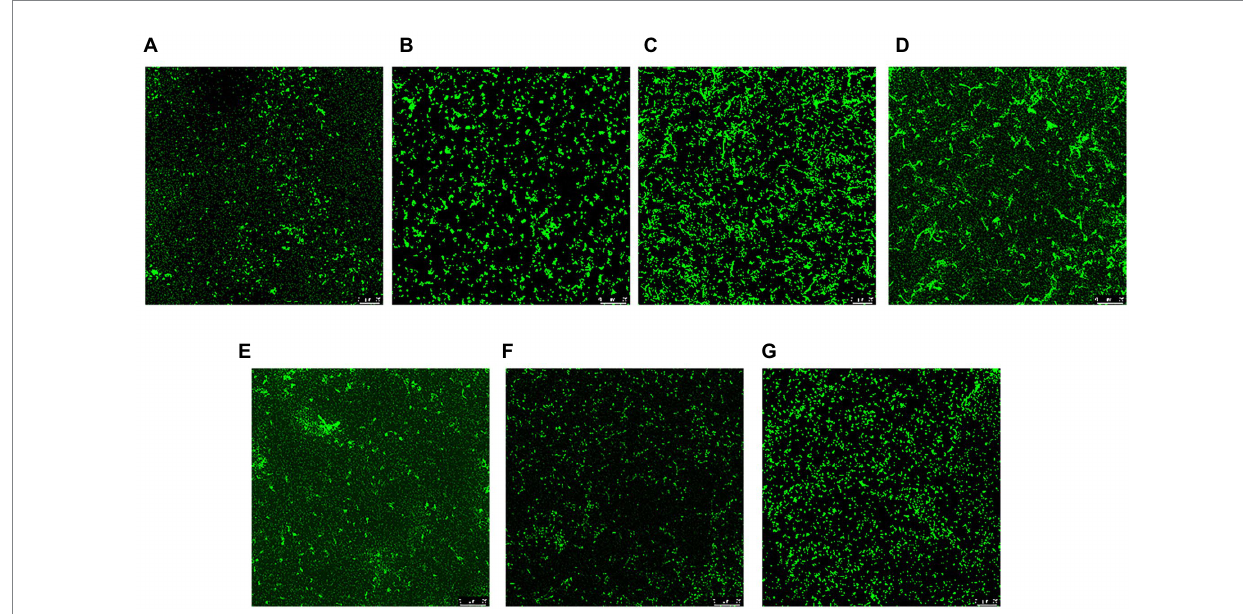
FIGURE 4 CLSM of Vibrio parahaemolyticus biofilm under different treatment conditions. (A) 1/2 MIC Cu 2+ treatment, (B) 1/4 MIC Cu 2+ treatment, (C) 1/2 MIC CARB treatment, (D) 1/4 MIC CARB treatment, (E) 1/2 MIC Cu 2+ +CARB treatment, (F) 1/4 MIC Cu 2+ +CARB treatment, (G) control.